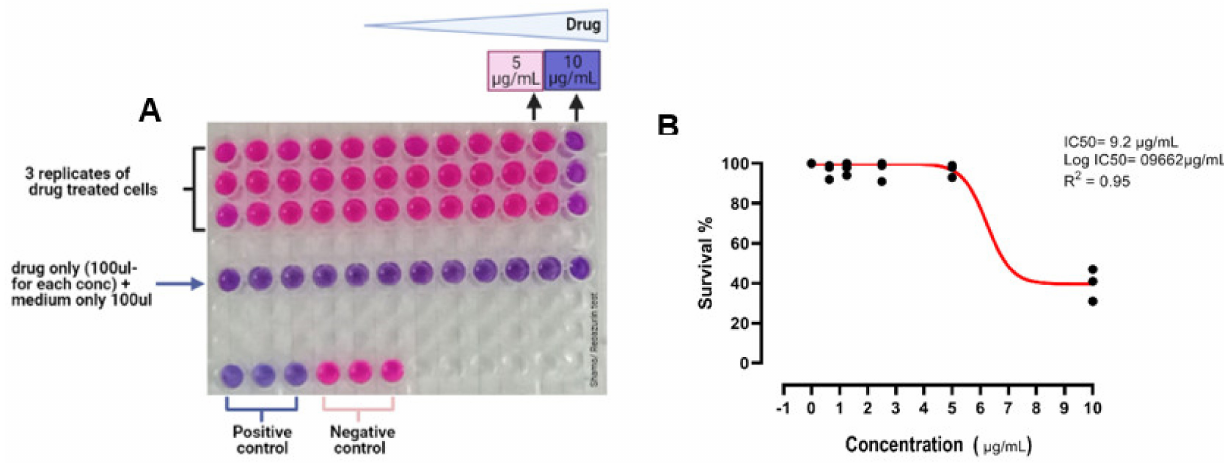
Figure 6. ( A ) 96-well plate showing resazurin reduction assay after 48 h; ( B ) dose-response curve showing the IC50 of IKA toward MAC-T